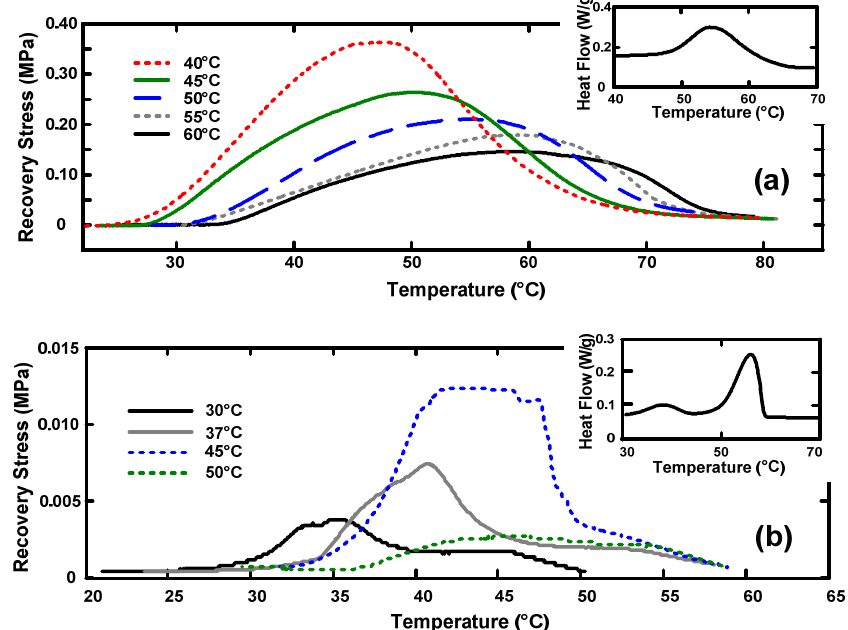
Figure 17. Evolution of recovery stress against heating temperature in melting glue ( a ); and paraffin wax ( b ), which are pre-programmed at different temperatures. Inset: DSC result (heat flow versus temperature) in heating process. (Reproduced with permission from [3]. Copyright 2012 Springer).